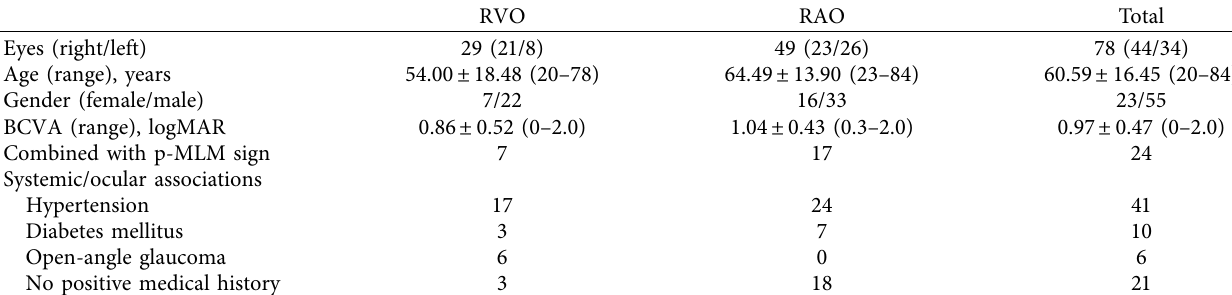
Table 1: Patient demographics and ocular findings in PAMM and p-MLM sign.